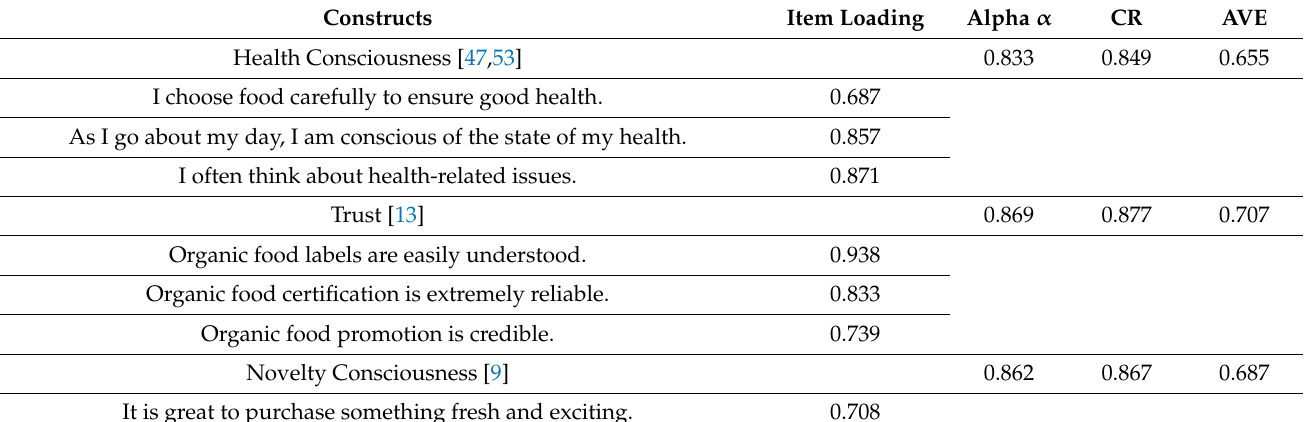
Table A1. Cronbach Alpha, Composite Reliability,